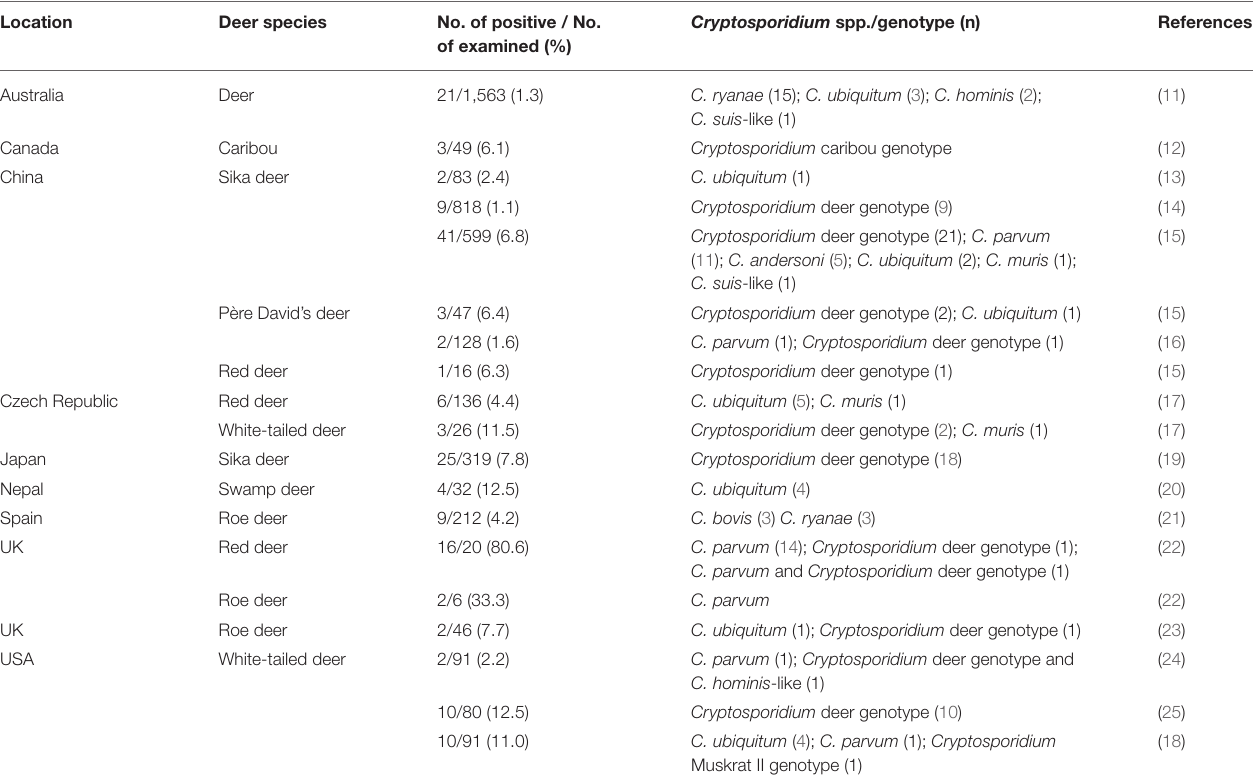
TABLE 1 | Prevalence and distribution of Cryptosporidium species/genotypes in deer according to country. Location Deer species No. of positive / No. of examined